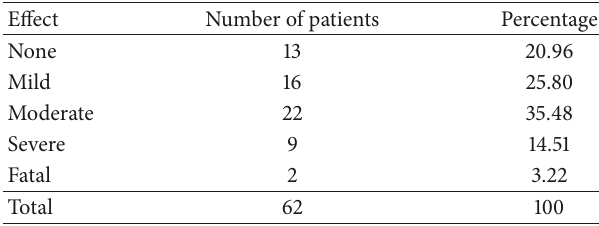
Table 2: Effect of the drug